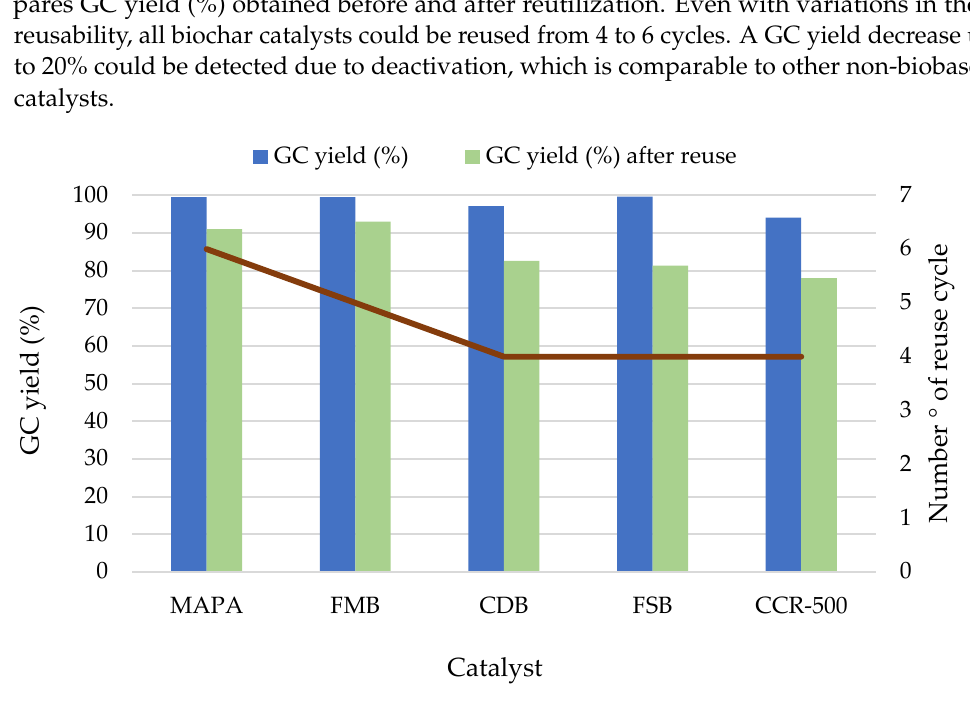
Figure 3. Comparison of GC yield (%) obtained before and after reutilization for several types of biobased catalysts made from different wastes.